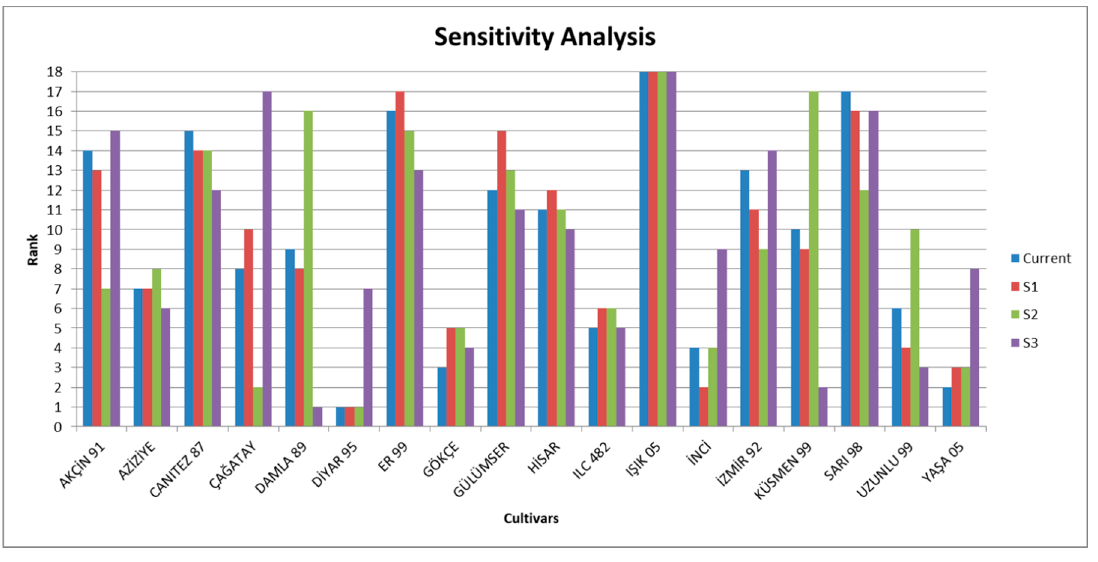
Figure 5. Scenario results.